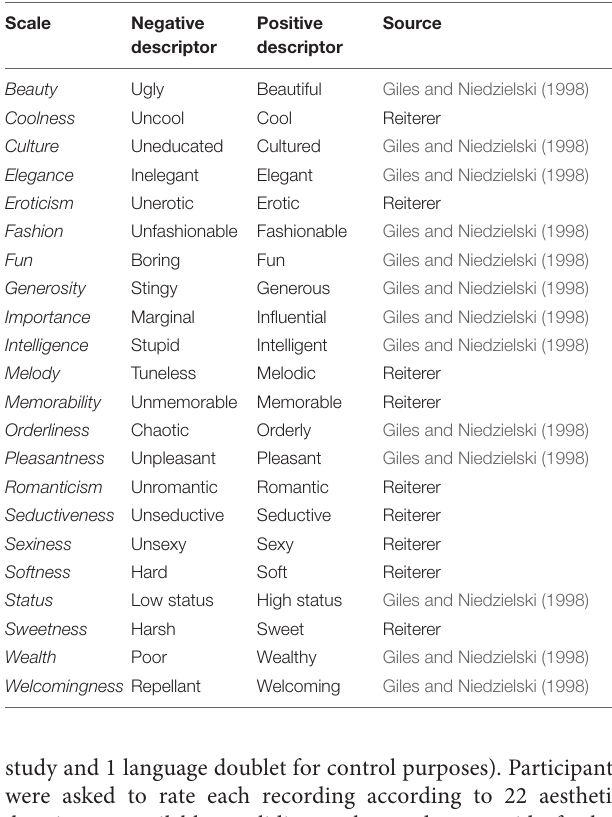
TABLE 2 | Aesthetic